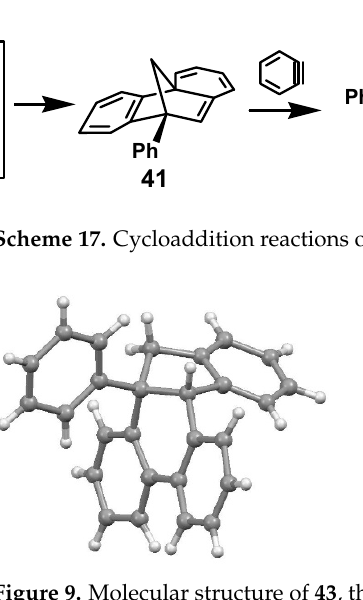
Scheme 17. Cycloaddition reactions of benzyne to 2-phenylindene.